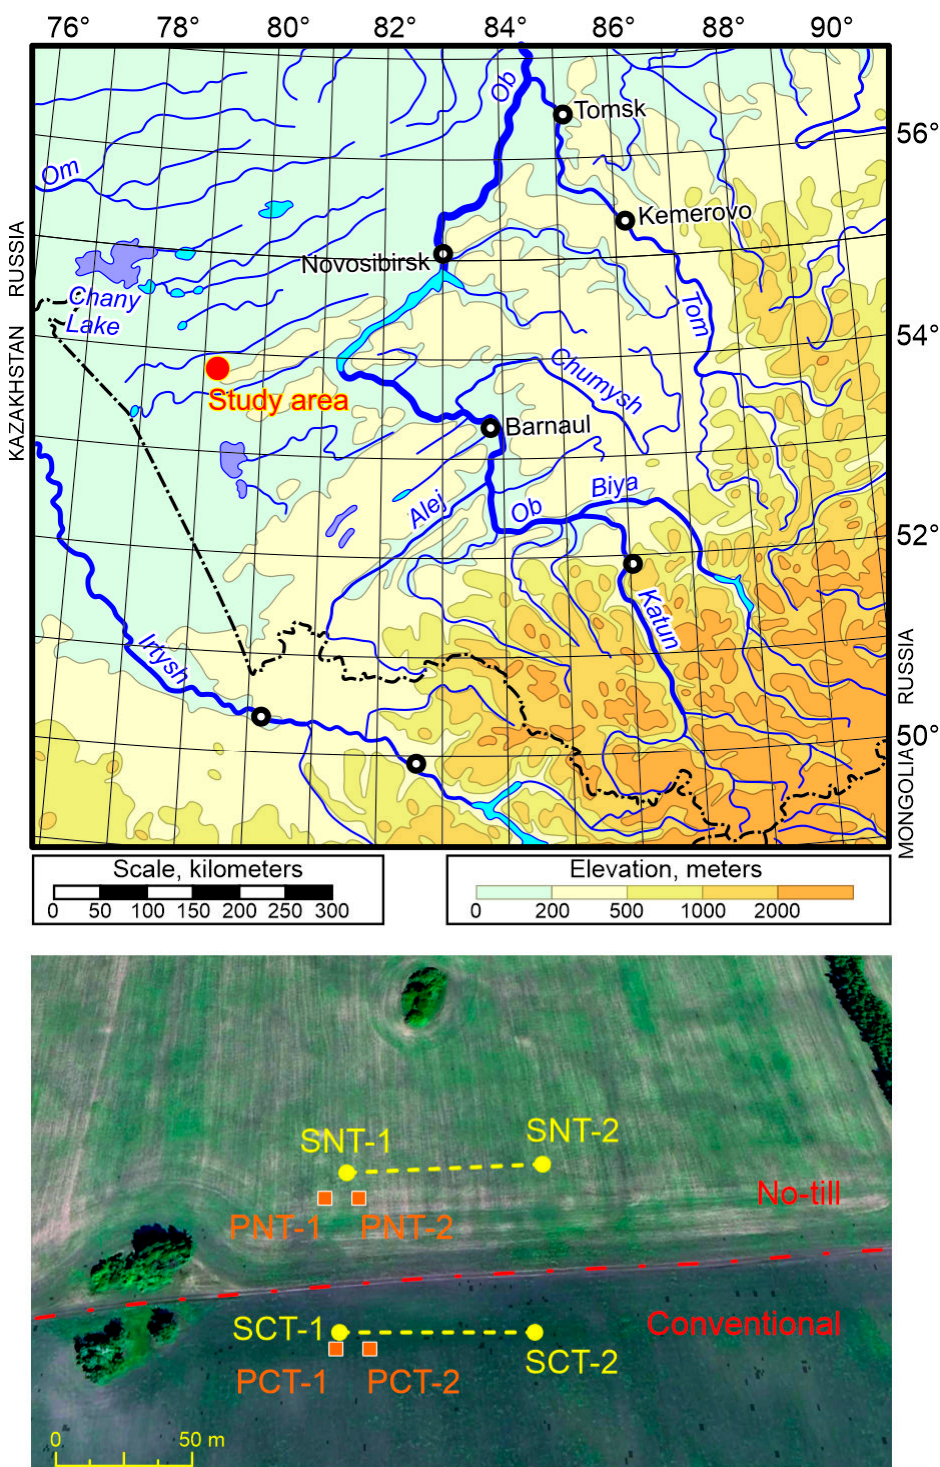
Figure 2. Geographic position (top), location of points with pitfall traps (squares), and the transects along which soil samples were taken (circles with dash line) (bottom). The boundary between the fields (passing along the road) is marked with a stippled line. SNT-1, SNT-2, SCT-1, SCT-2: west and east points of the transect of soil samples in no-till (NT) and in conventional (CT) plots, respectively; PNT-1, PNT-2, PCT-1, PCT-2: locations of pitfall trap “five spot patterns” in no-till (NT) and in conventional (CT) plots, respectively.